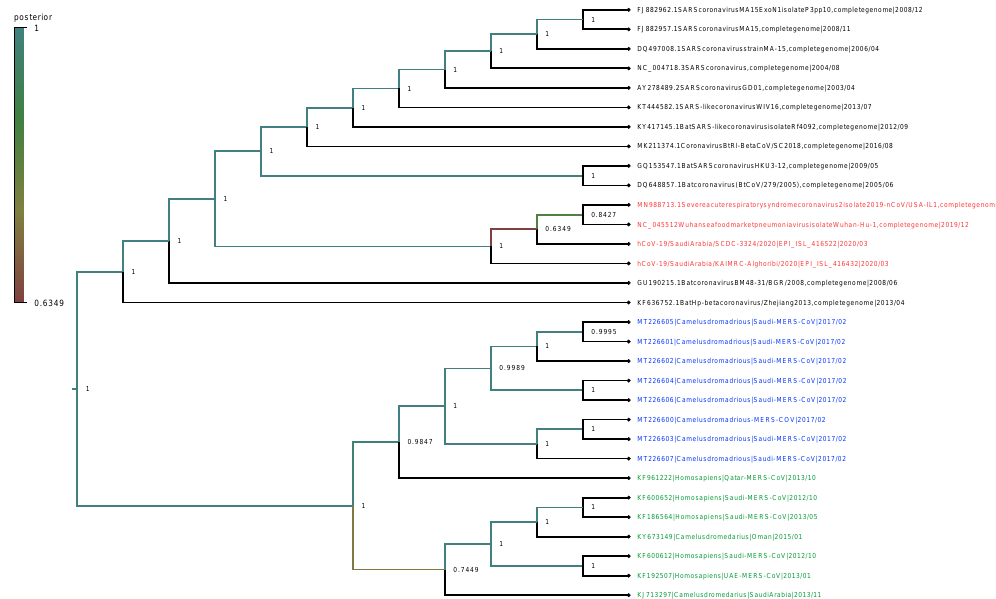
Figure 1. Phylogenetic analysis of the complete genomes of our eight MERS-CoV isolates and representative viruses of the genus Betacoronavirus. The new eight isolates are in blue, other MERS-CoV strains in green, and 2019-nCoV in red. The numbers at nodes represent the posterior probabilities of their clustering.